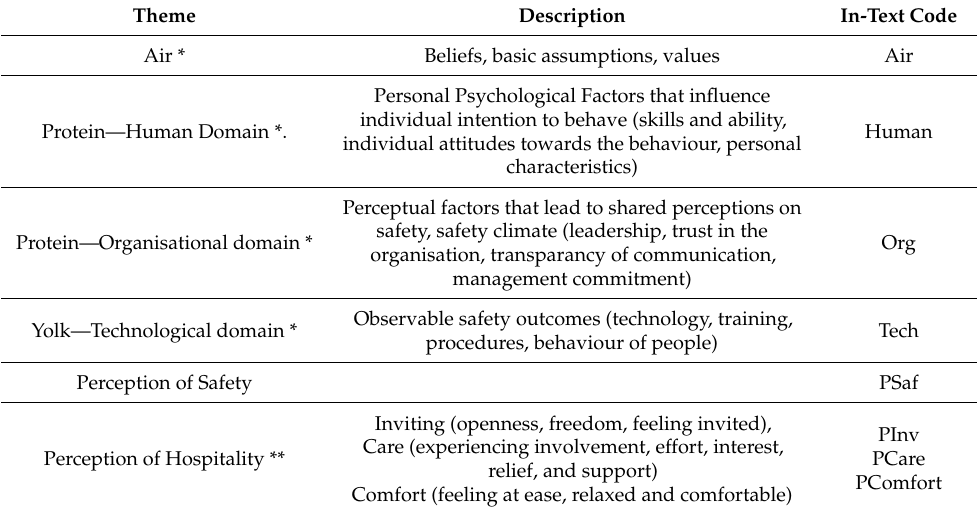
Table 2. Initial coding into themes, based on The Egg Aggregated Model and Experience of Hospital- ity